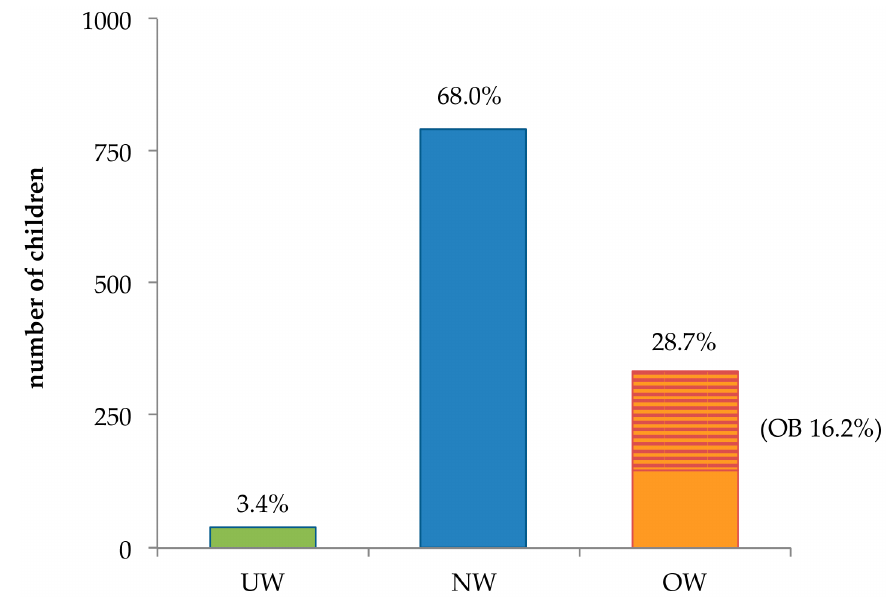
Figure 1. Percentage distribution in the various weight categories of children participating in the MAPEC_LIFE (Monitoring Air Pollution Effects on Children for Supporting Public Health Policy) study. UW = underweight, NW = normal weight, OW = overweight, OB = obese.